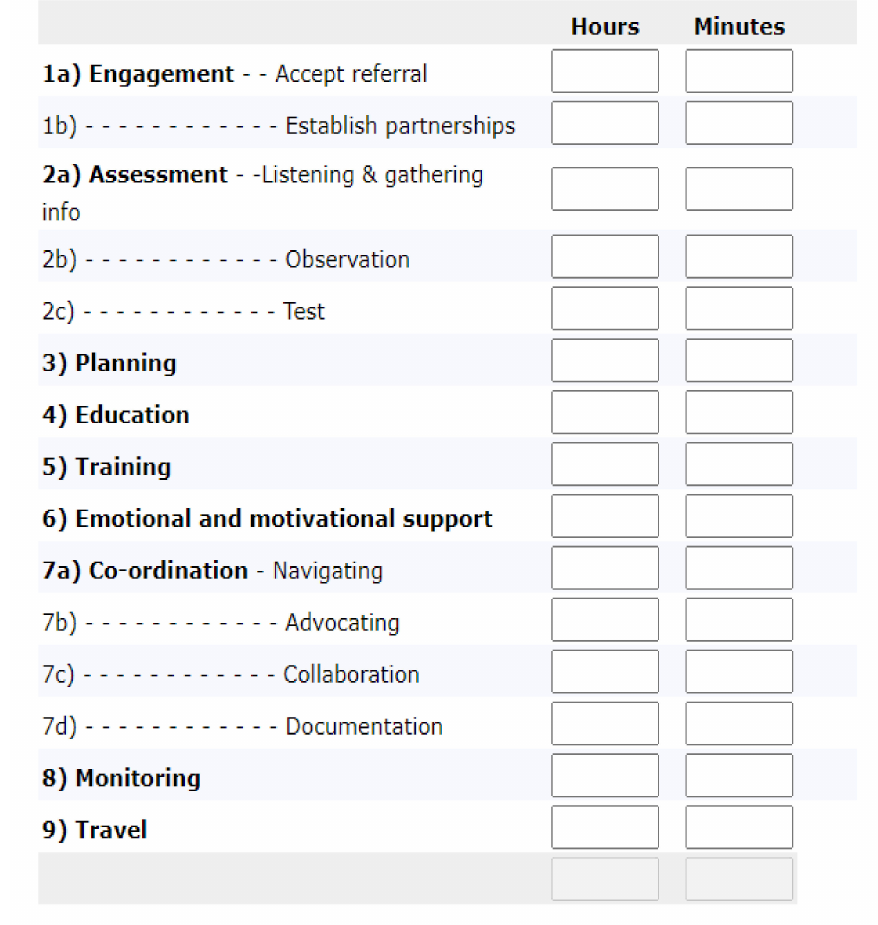
Figure 1. Survey form for the VIP time recording